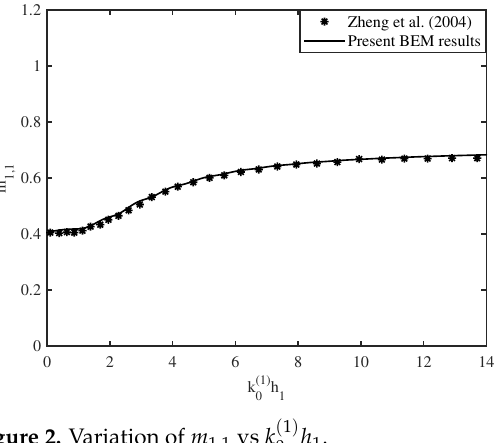
Figure 2. Variation of m 1,1 vs k